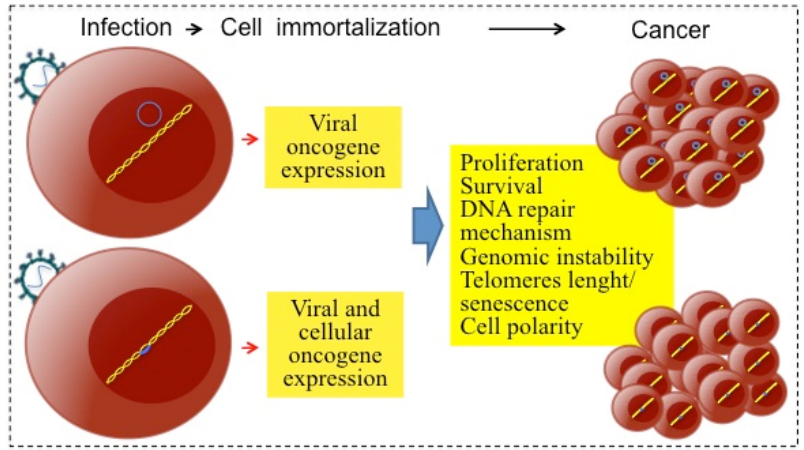
Figure 1. Direct mechanisms of viral carcinogenesis. After infecting target cells, tumor viruses are persistently maintained as genetic elements; viral genomes can form episomes (upper panel example, herpesviruses) or integrate into the host genomic DNA (lower panel example, retroviruses and